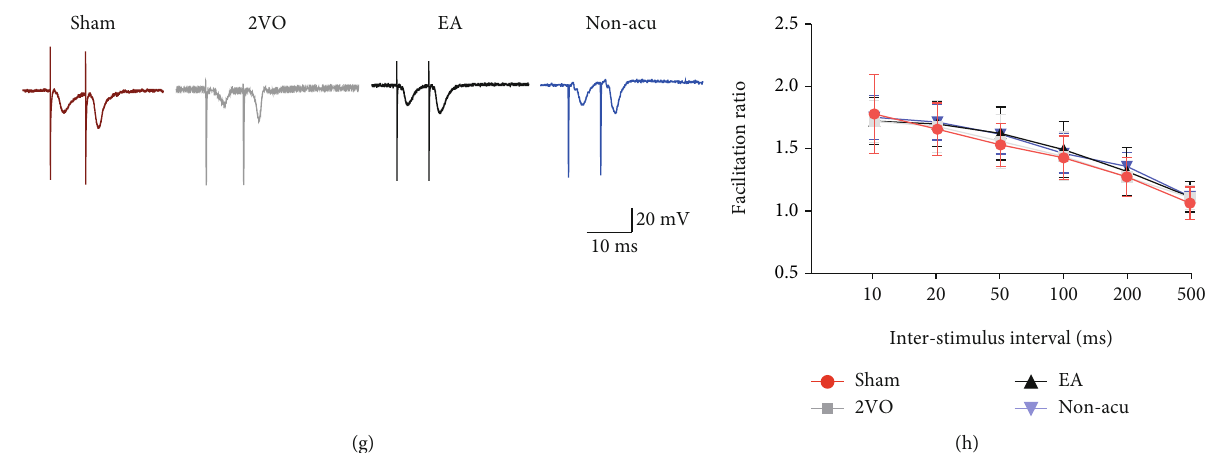
Figure 2: Electroacupuncture improves synaptic plasticity of hippocampal CA3 – CA1 neural circuit in VCI rats. (a) Schematic representation of the hippocampal circuit and positioning of the stimulating and recording electrodes for LTP at the Sha ff er collateral- CA1 synapses (CA3 – CA1 LTP). (b) A schematic diagram showing the generation of LTP. (c) Successful recording of LTP via patch- clamp. (d) Quanti fi cation of LTP elicited in the CA3 – CA1. (e) The I/O curves for all recorded group are summarized. (f) I/O curve recordings in the CA3 – CA1 region of the hippocampus in each group of rats. (g) Representative paired-pulse ratio (PPR) with di ff erent interpulse intervals at CA3 – CA1. (h) Results of PPR recordings in the hippocampal CA3 – CA1 region of rats in each group. ∗ P < 0 : 05 and ∗∗ P < 0 : 01 , Sham vs. 2VO; # P < 0 : 05 , 2VO vs. EA; ^ P < 0 : 05 , EA vs.